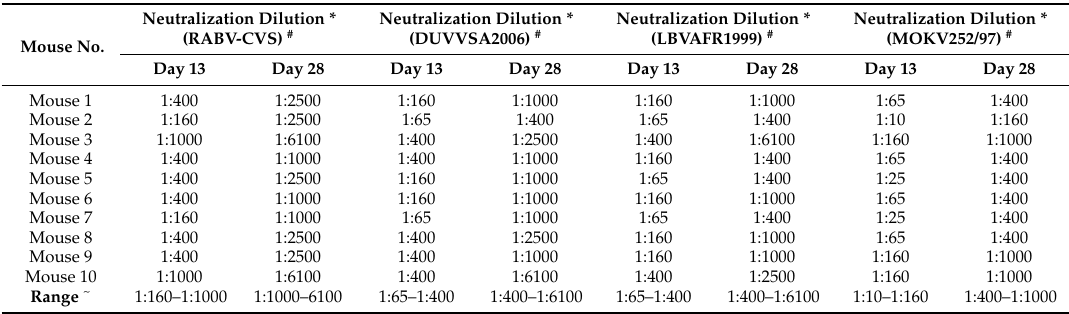
Key: * Represents the dilution where there was 50% virus neutralization by the serum. The experiments were performed in triplicate; # Indicates the challenge virus used; ~ Indicates the range of virus neutralization titer between the different